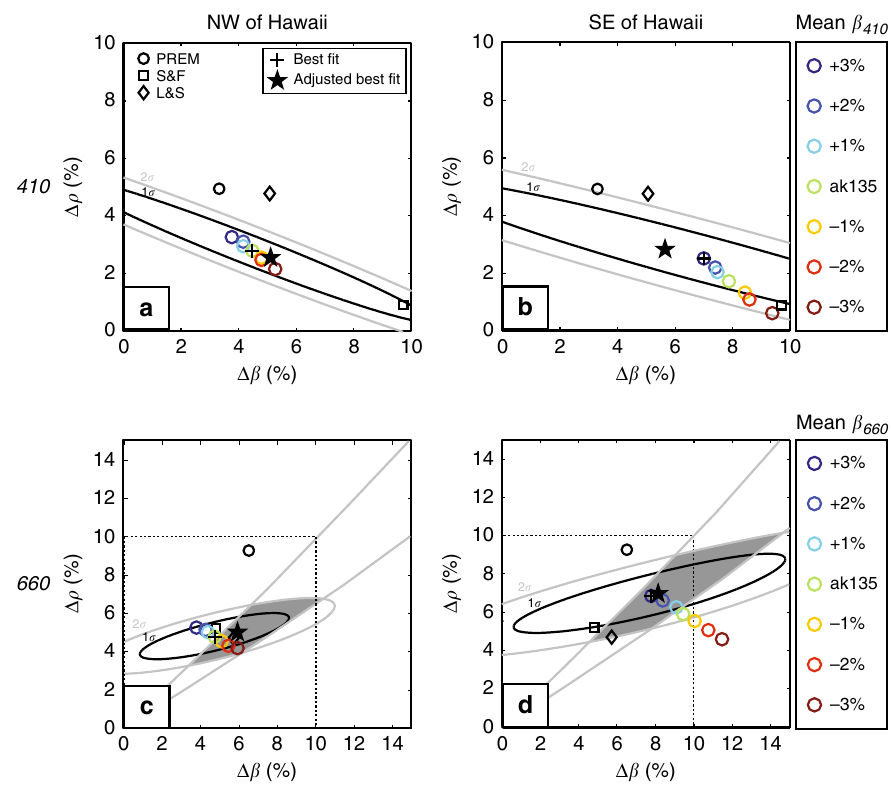
Fig. 5 Density and wavespeed contrasts across the discontinuities calculated from data NW and SE of Hawaii. Panels a , b are for the 410 , and c , d for the 660 . Black and gray ellipses mark the 1 σ and 2 σ limits of parameters based on fi tting amplitudes (black circles in Fig. 4c – f) using chi-squared statistics. Gray lines in c and d mark 2 σ limits from estimates of the zero-re fl ection distance (Fig. 4a, b). Black crosses depict the best fi tting models and black stars are the best fi ts after thermodynamic adjustment. Colored circles illustrate how best fi tting models vary as a function of mean wavespeed β (in per cent deviations from ak135). For comparison, black open symbols represent values from PREM, and the global models of Shearer and Flanagan 23 (S&F) and Lawrence and Shearer 49